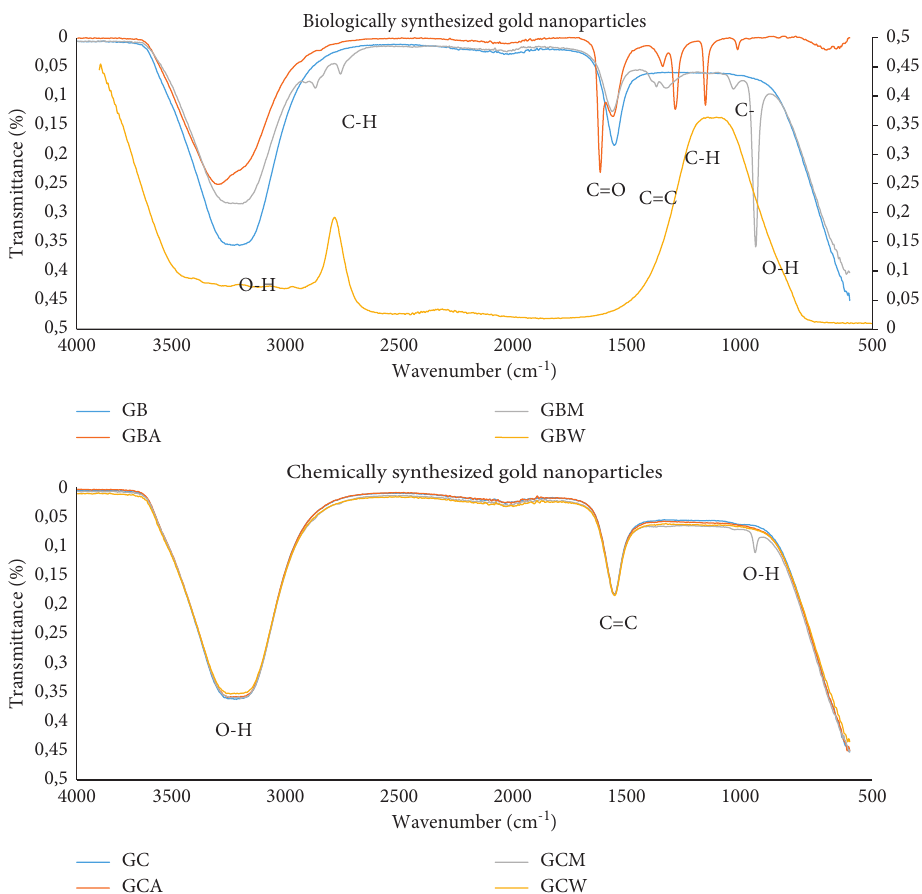
Figure 5: FTIR spectra of plant extracts conjugated with gold nanoparticles. GB: biologically synthesized gold nanoparticles, GBA: bi- ologically synthesized gold nanoparticles and acetone extract, GBM: biologically synthesized gold nanoparticles and methanol extract, GBW: biologically synthesized gold nanoparticles and water extract, GC: chemically synthesized gold nanoparticles, GCA: chemically synthesized gold nanoparticles and acetone extract, GCM: chemically synthesized gold nanoparticles and methanol extract, and GCW: chemically synthesized gold nanoparticles and water